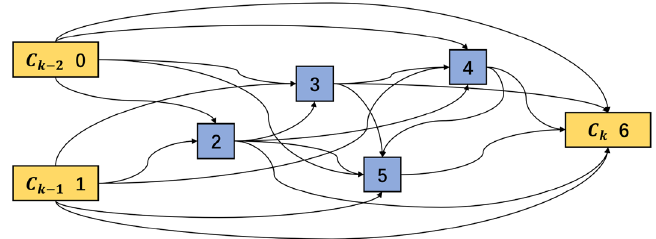
Figure 1. Cell structure with seven nodes.